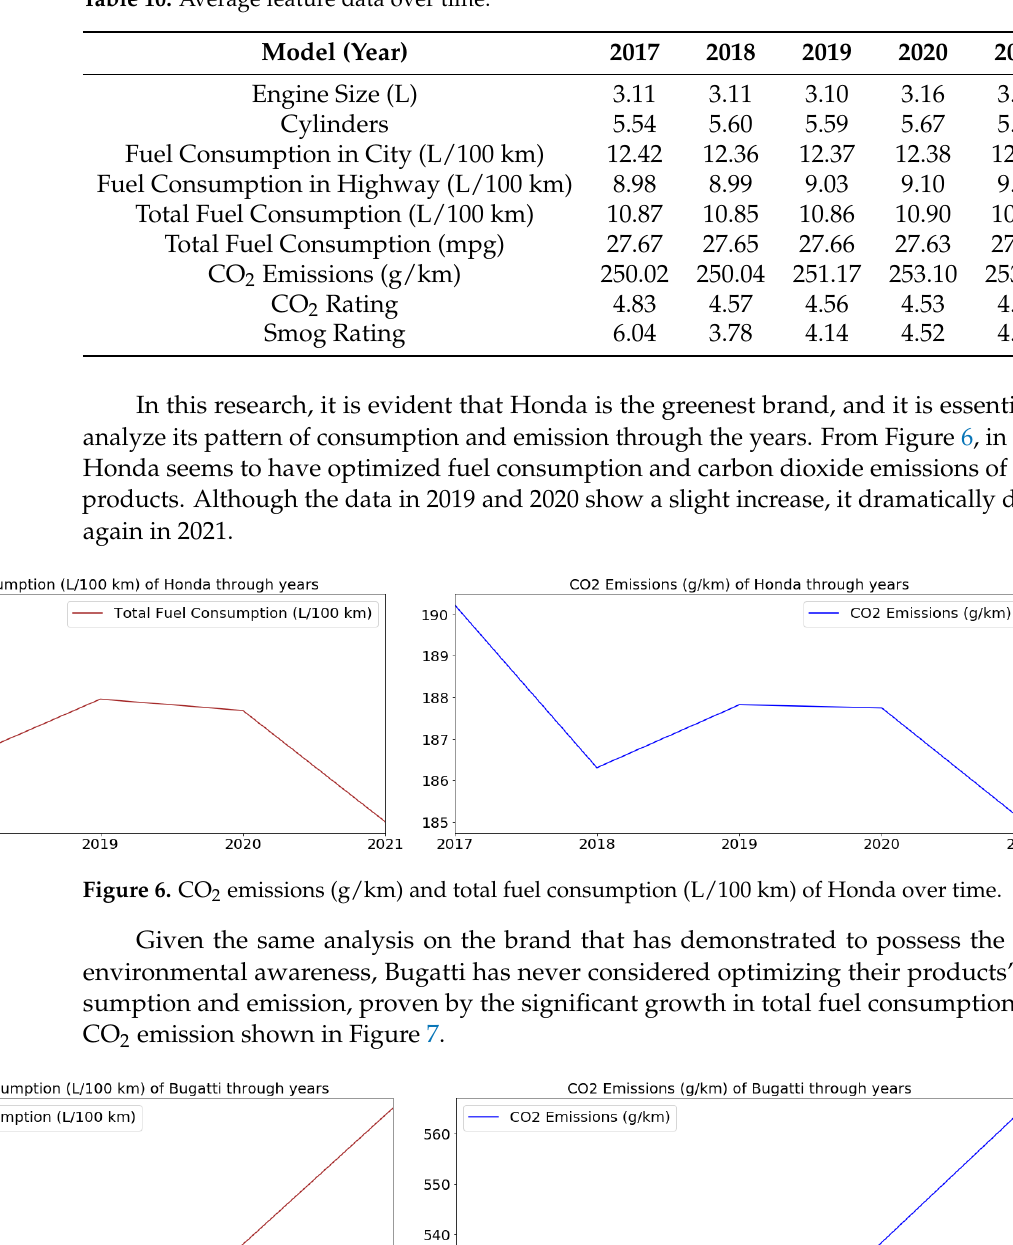
Table 10. Average feature data over time.